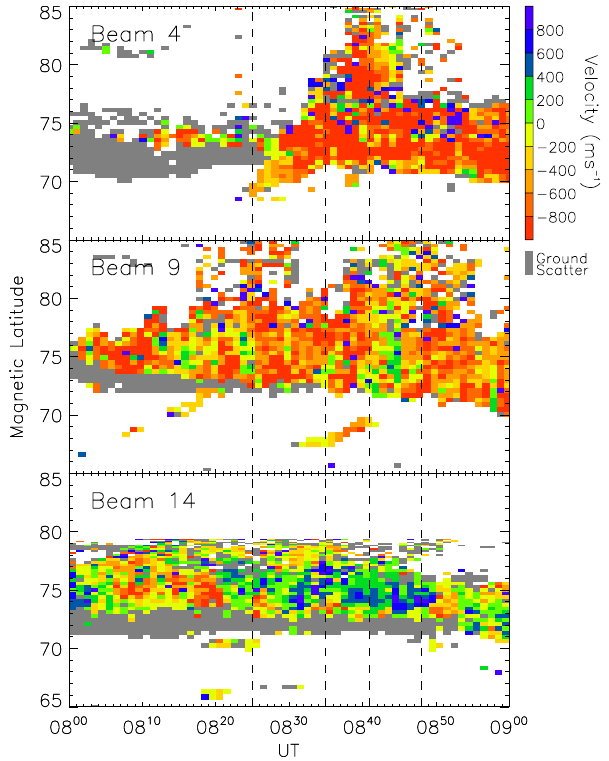
Fig. 7. Line of sight ion drift velocities as a function of magnetic lat- itude and time, obtained from beams 4, 9, and 14 of the CUTLASS HF radar during 08:00–09:00UT. Velocities are colour-coded ac- cording to the scales to the right. Four successive auroral brighten- ing events are marked by vertical guidelines at 08:25, 08:35, 08:41, and